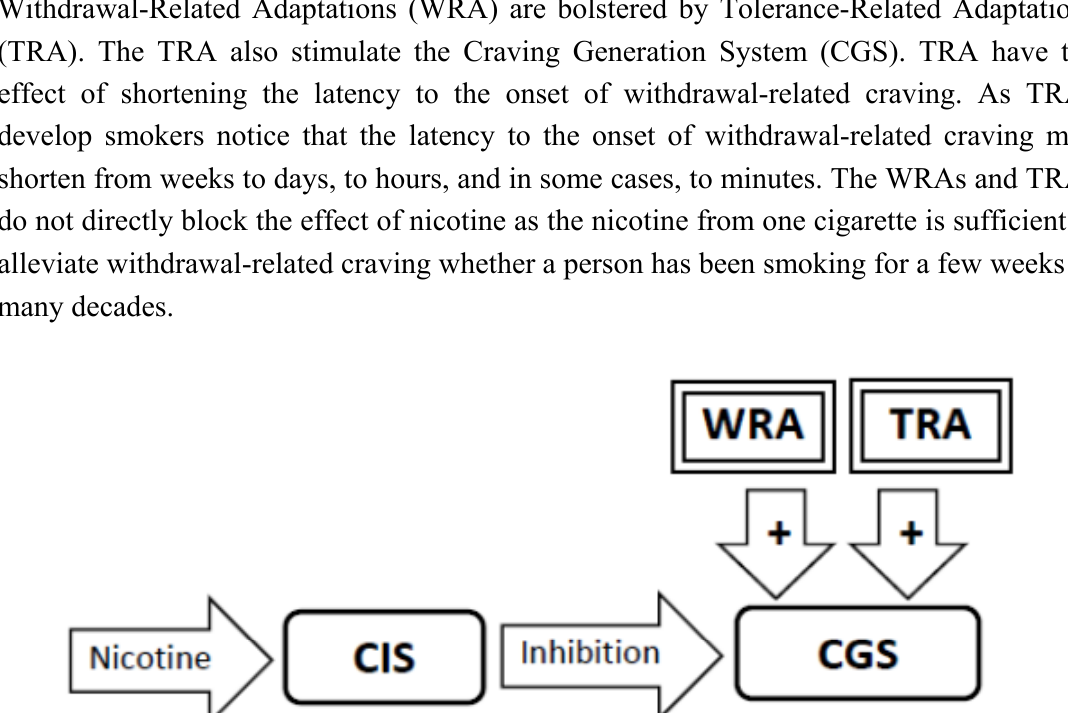
Figure 5. Repeated exposures to nicotine promote additional neuroadaptation. The Withdrawal-Related Adaptations (WRA) are bolstered by Tolerance-Related Adaptations (TRA). The TRA also stimulate the Craving Generation System (CGS). TRA have the effect of shortening the latency to the onset of withdrawal-related craving. As TRAs develop smokers notice that the latency to the onset of withdrawal-related craving